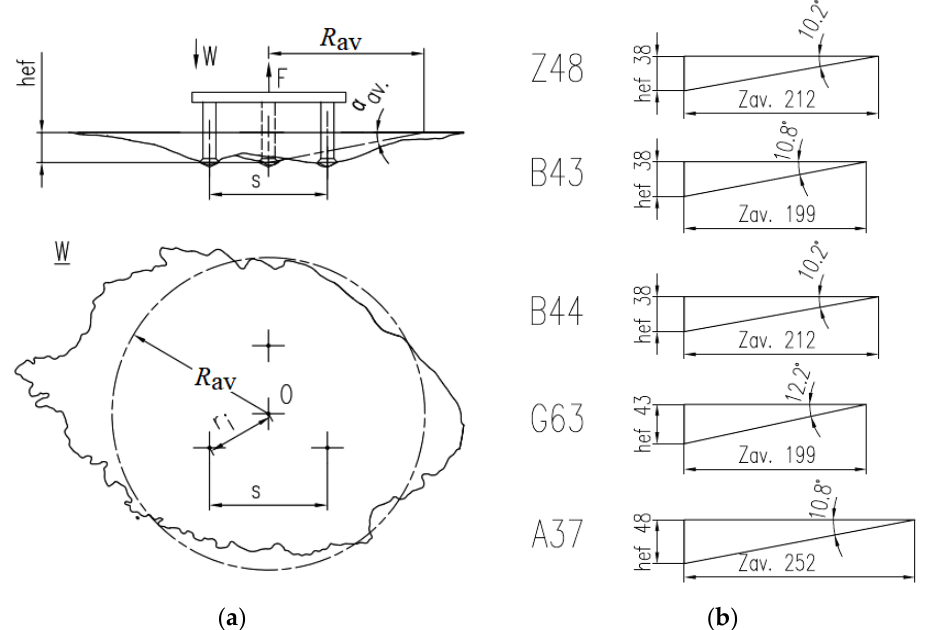
Figure 16. Mean failure cone parameters for a group of 3 anchors ( a ), mean failure cone angles measured in subsequent breakout tests ( b ). R av —failure cone base diameter, α av —mean failure cone angle.